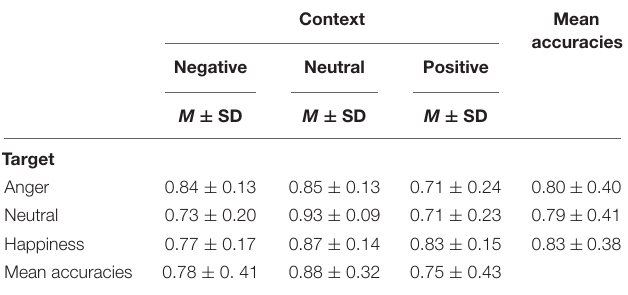
TABLE 1 | Means and standard deviations of accuracies in all